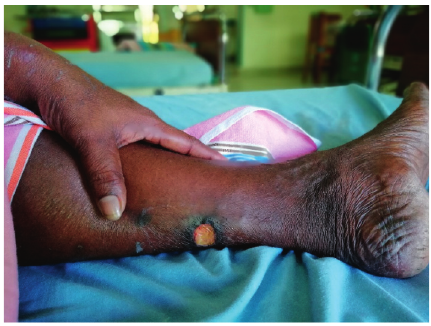
Figure 3: Punched out ulcer over the left